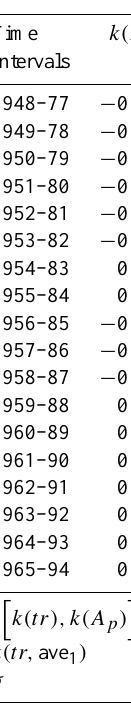
Table 2. The k values (Sverdlovsk, 10:00LT)